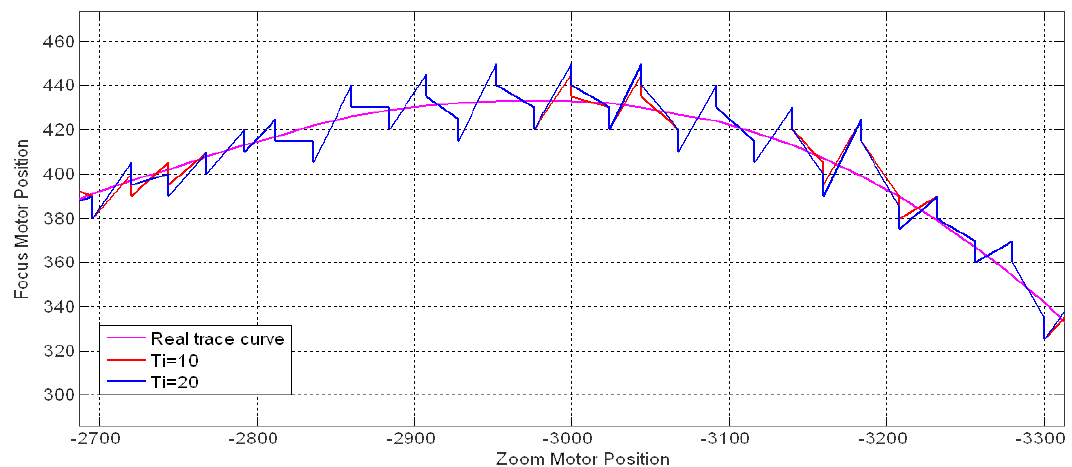
Figure 22. Complementary response curves for different integral time.